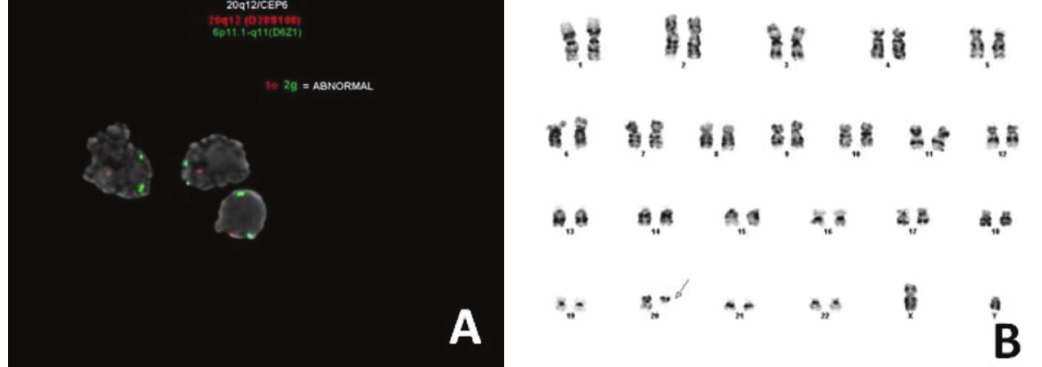
Figure 3: FISH and cytogenetics analysis. (A) FISH performed on a touch preparation of representative lymph node tissue shows only one positively tagged 20q12 (red signal) per cell. Control tag 6p11 (green) shows dual positivity. FISH is diagnostic for del(20q12). (FISH probes from Abbott Molecular, Inc.) (B) Karyotype of bone marrow aspirate. Cytogenetics performed on bone marrow tissue reveals deletion of 20q11.2